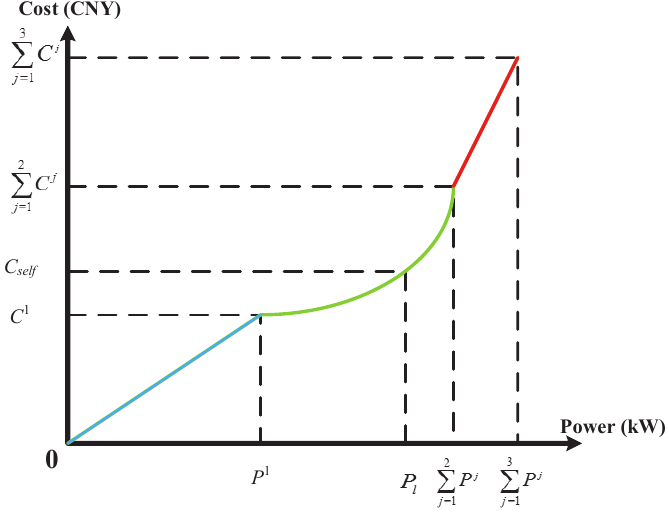
Figure 4. Example of operation cost of distributed energy resources (DERs) in an MG.